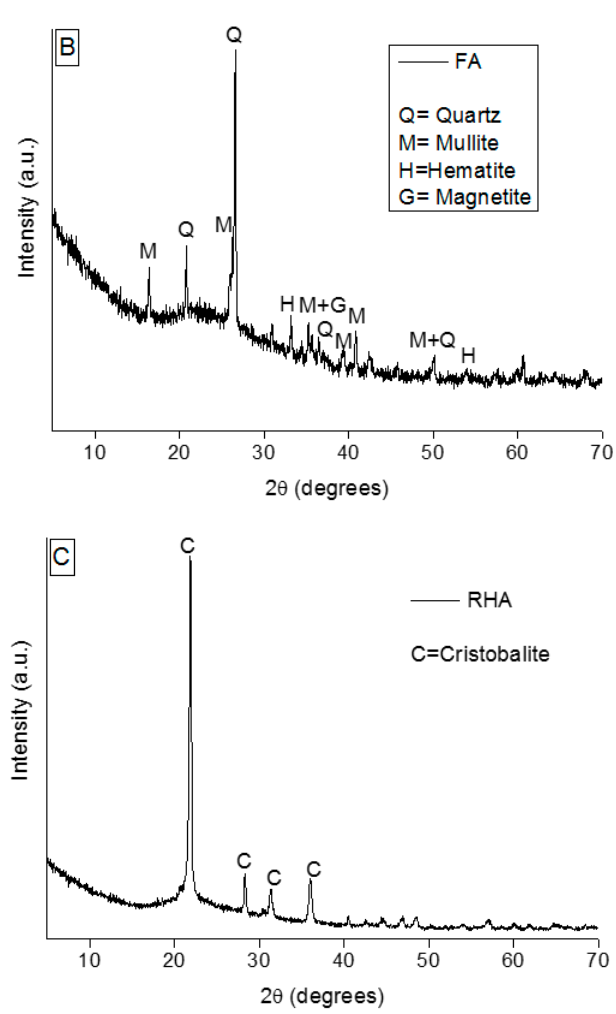
Figure 1. XRD patterns of: ( A ) as-received (thin line) and calcined (thick line) halloysite (HL); ( B ) fly ash (FA); ( C ) rice husk ash (RHA).